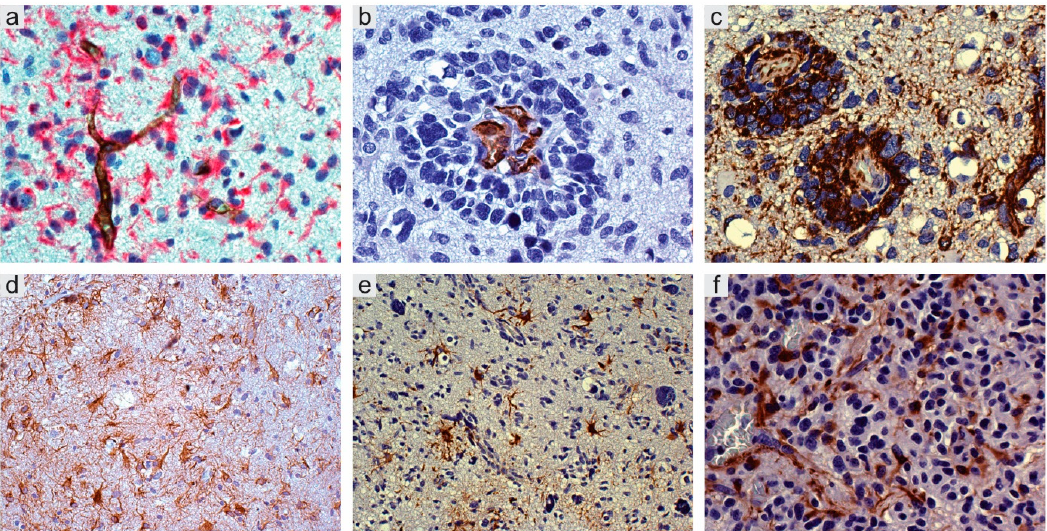
Figure 1. Glioblastoma, IDH wild type. ( a ) CD34+ endothelial cells of arterioles and capillaries in direct contact with Nestin+ tumor cells; double immunostaining with CD34 (DAB) and Nestin ( Fast Red ), original magnification (OM) ×400. ( b ) Vessel co-option. Sleeve of tumor cells around capillaries; CD34, DAB, OM ×400. ( c ) Id ., with several Nestin+ tumor cells; DAB, OM ×200. ( d ) Mild infiltration. Reactive astrocytes on small vessels; GFAP, DAB, OM ×200; ( e ) More intense infiltration. Reactive astrocytes on vessels; GFAP, DAB, OM ×200; ( f ) High infiltration. Reactive astrocytes with end-feet on small vessels; GFAP, DAB, OM ×400. IDH, isocitrate dehydrogenase; DAB, 3,3 ′ - Diaminobenzidine .